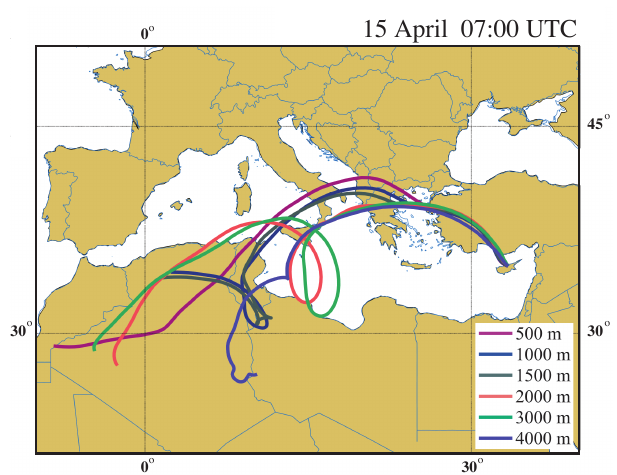
Figure 6. Back-trajectories of the air masses arriving at various alti- tudes over Cyprus on 15 April, 07:00(UTC). The back-trajectories were calculated for a duration of 5 days using the HYSPLIT trans- port and dispersion model (Rolph, 2003; Stein et al., 2015) with GDAS 1 ◦ meteorological data through the Real-time Environmental Applications and Display sYstem (READY; http://ready.arl.noaa. gov/index.php, last access: 26 June